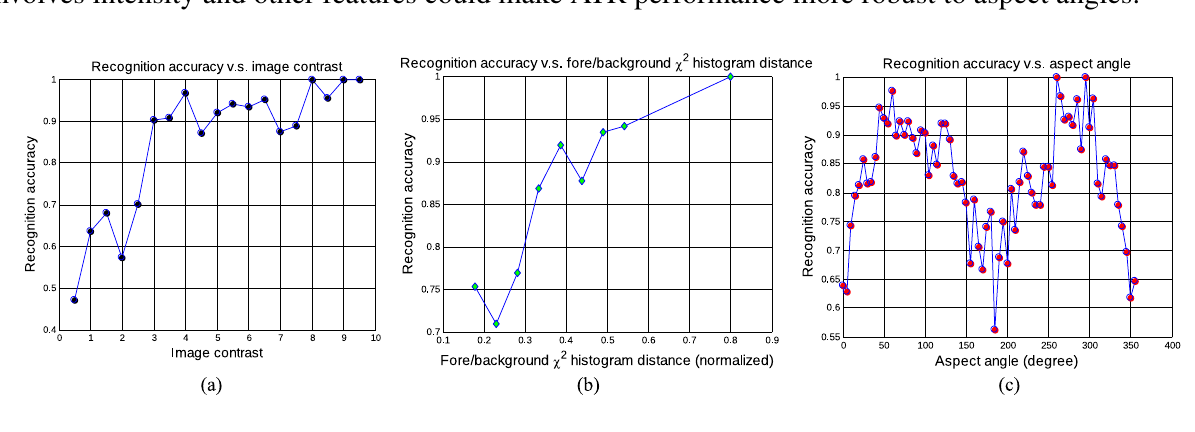
Figure 10. Robustness analysis of GB-PSO over all 2400 chips. ( a ) Recognition accuracy versus the chip contrast; ( b ) recognition accuracy versus foreground/background histogram distances; ( c ) recognition accuracy versus the aspect angles.